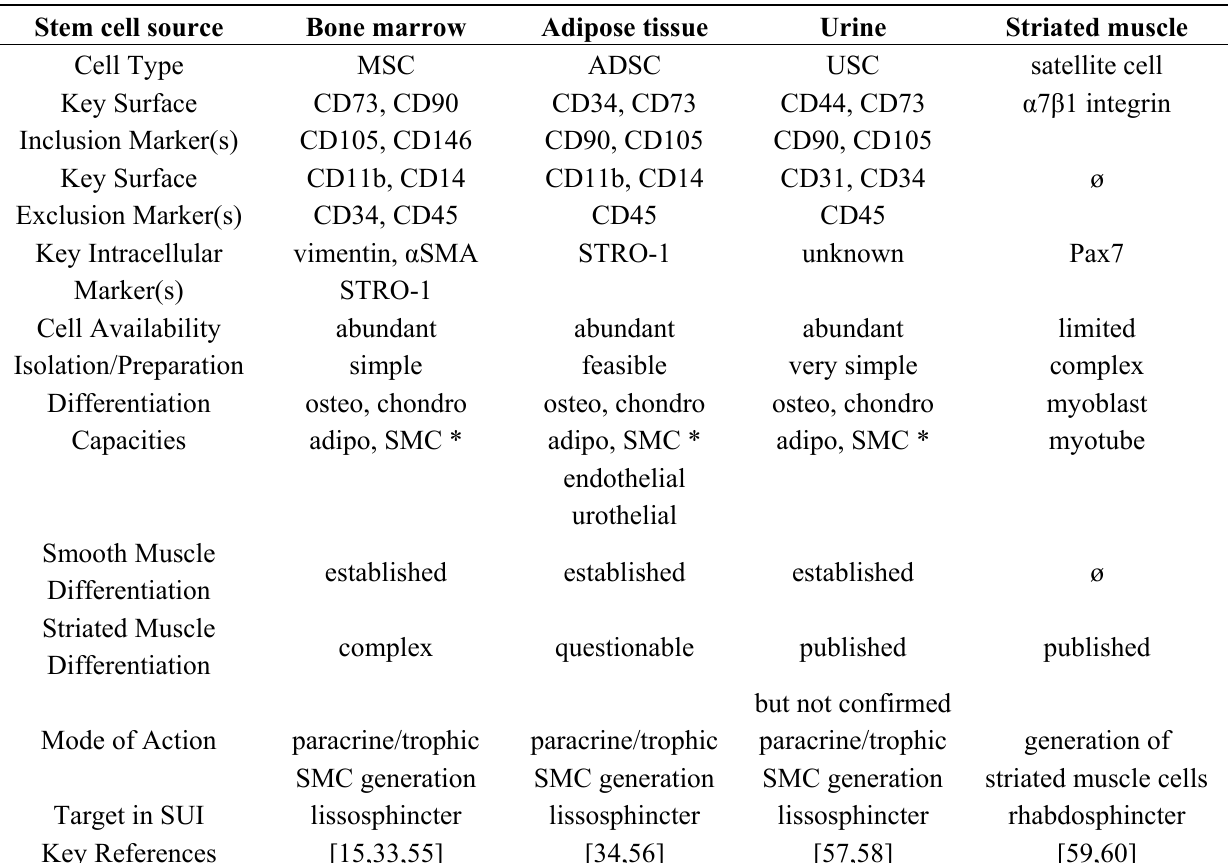
Table 1. Selected features of human stem or progenitor cells suitable for regeneration of the urinary sphincter in the context cell based therapies for stress urinary incontinence (* SMC: smooth muscle